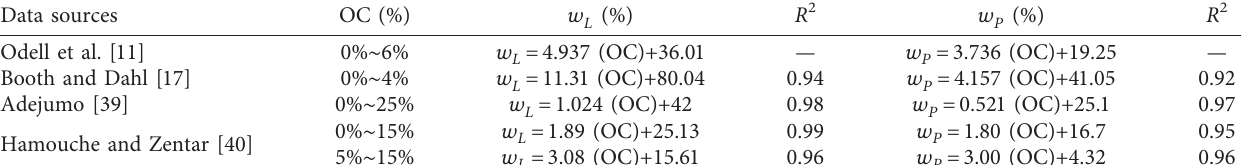
w L ) and plastic limit ( p ).